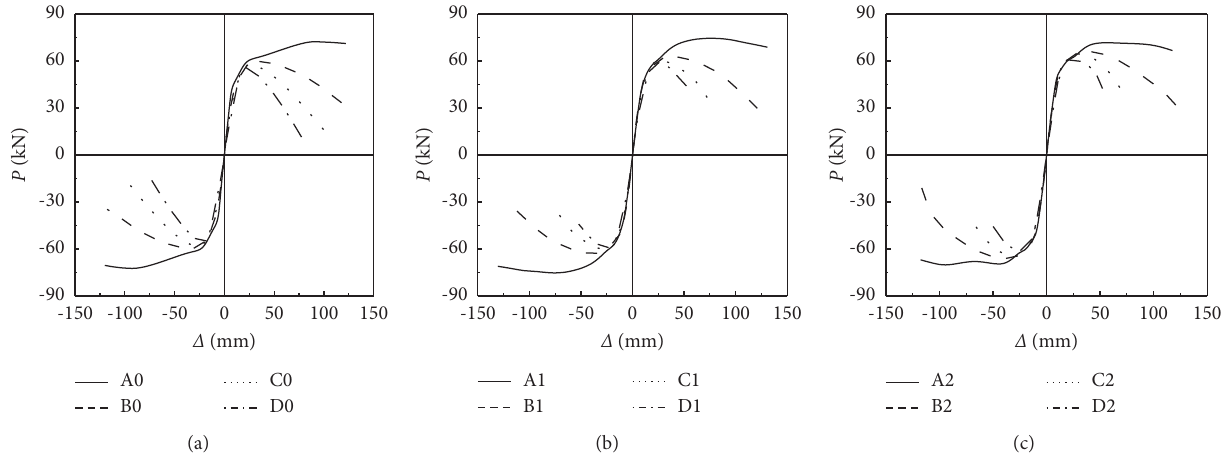
Figure 10: Effect of axial compression ratio on P - Δ skeleton curve of specimens. (a) η � 0 specimens. (b) η � 0.157 specimens. (c) η � 0.314 specimens.